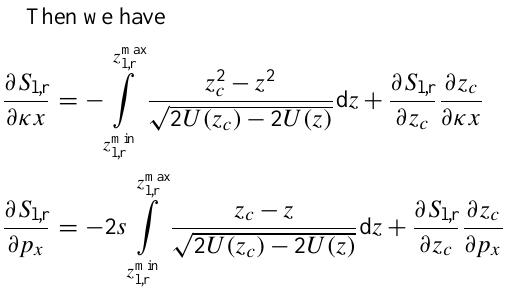
Table A1. Integrals =